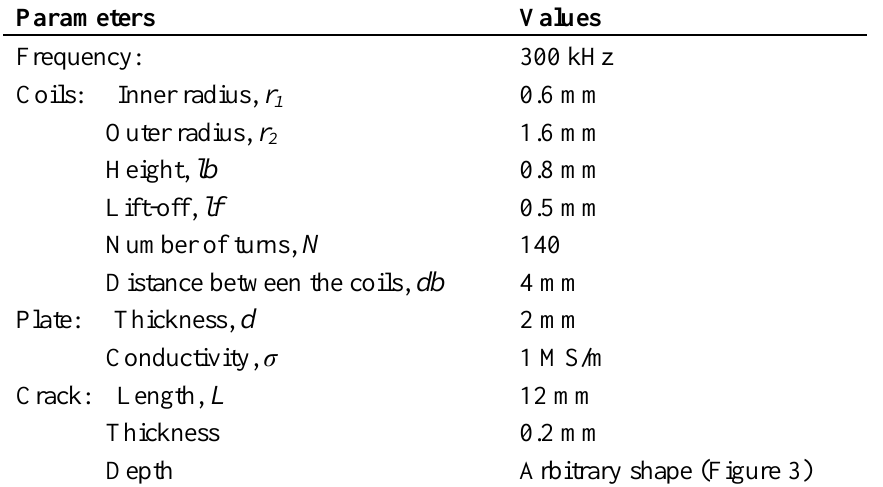
Table 1. The Fixed parameter of the modeled